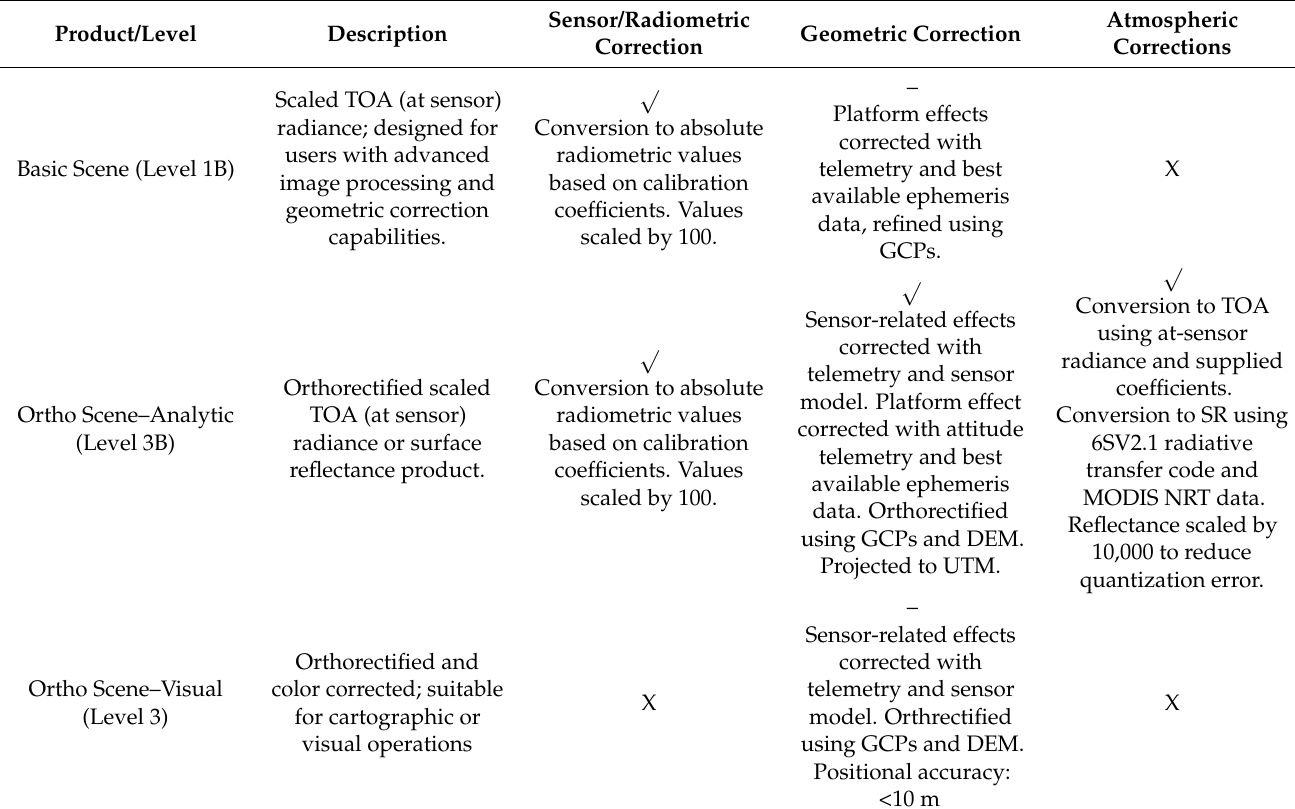
Table 2. Product levels with descriptions of radiometric, geometric, and atmospheric corrections for three PlanetScope √ Products. = most complete, – = less complete, X = no corrections.